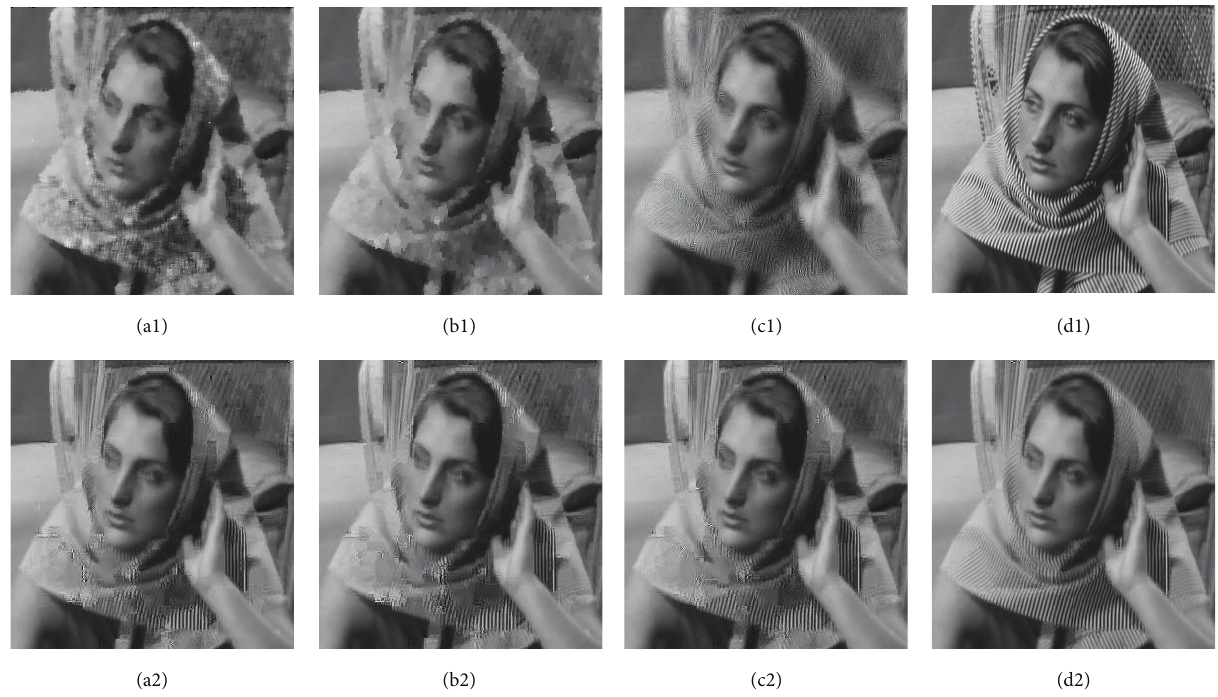
Figure 7: Denoised Barbara images with 50% salt-and-pepper noise. (a1), (b1), and (c1) are initial guide image using median filtering, total variation, and wavelet, respectively; (d1) original image; (a2), (b2), (c2), and (d2) are denoising results of the proposed method using (a1), (b1), (c1), and (d1) as the initial guide image,